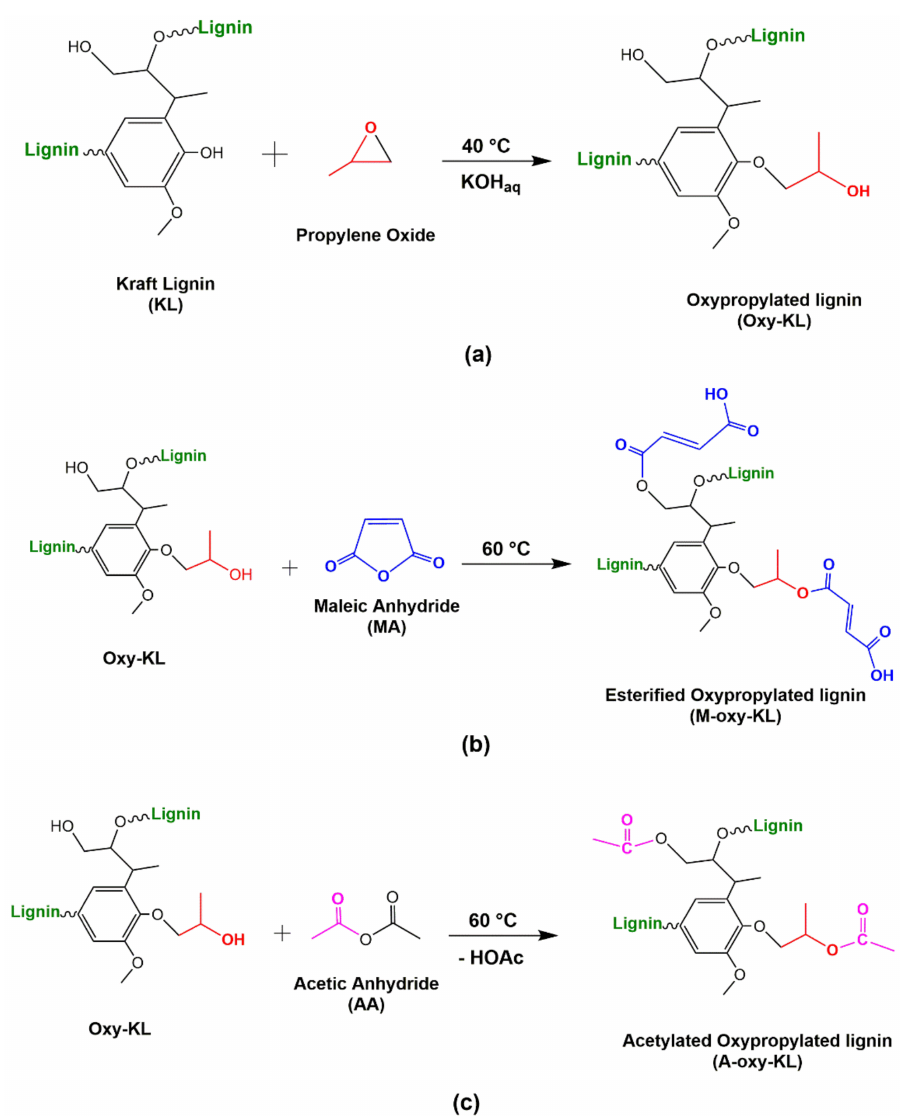
Figure 1. Chemical reactions employed in the lignin modification: ( a ) Hydroxypropylation with propylene oxide; ( b ) Esterification with maleic anhydride; and ( c ) Acetylation with acetic